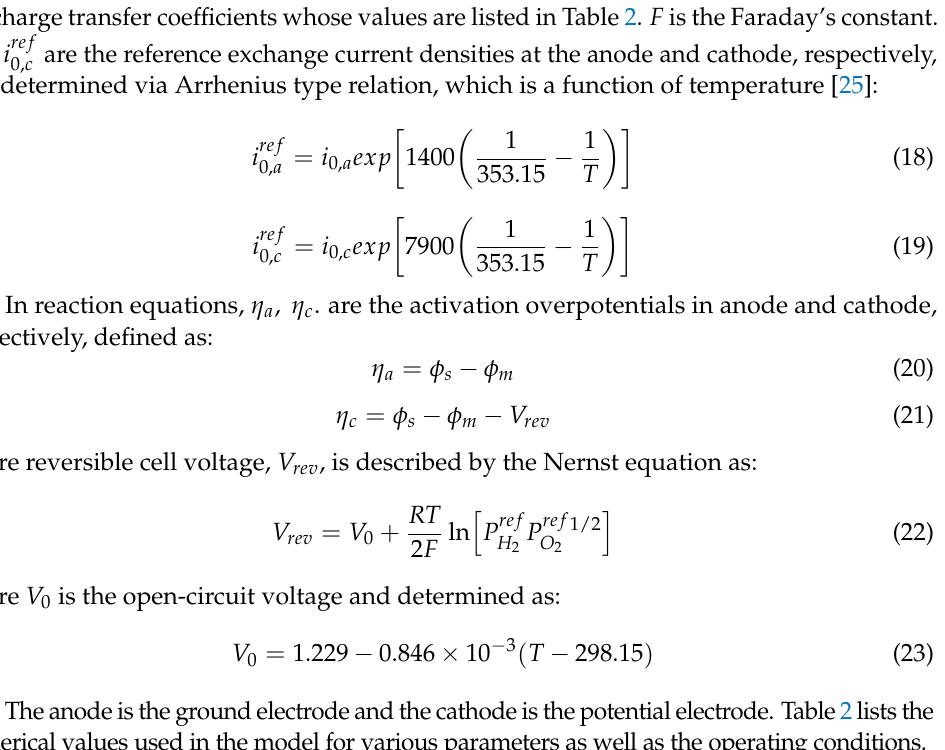
Table 2. Physical properties and base operating conditions in the model. Property, Symbol Value, Unit Exchange current density in anode and cathode, i 0, a , i 0, c 10 2 , 10 − 3 Charge transfer coefficients, α a , a , α c , a , α a , c , α c ,